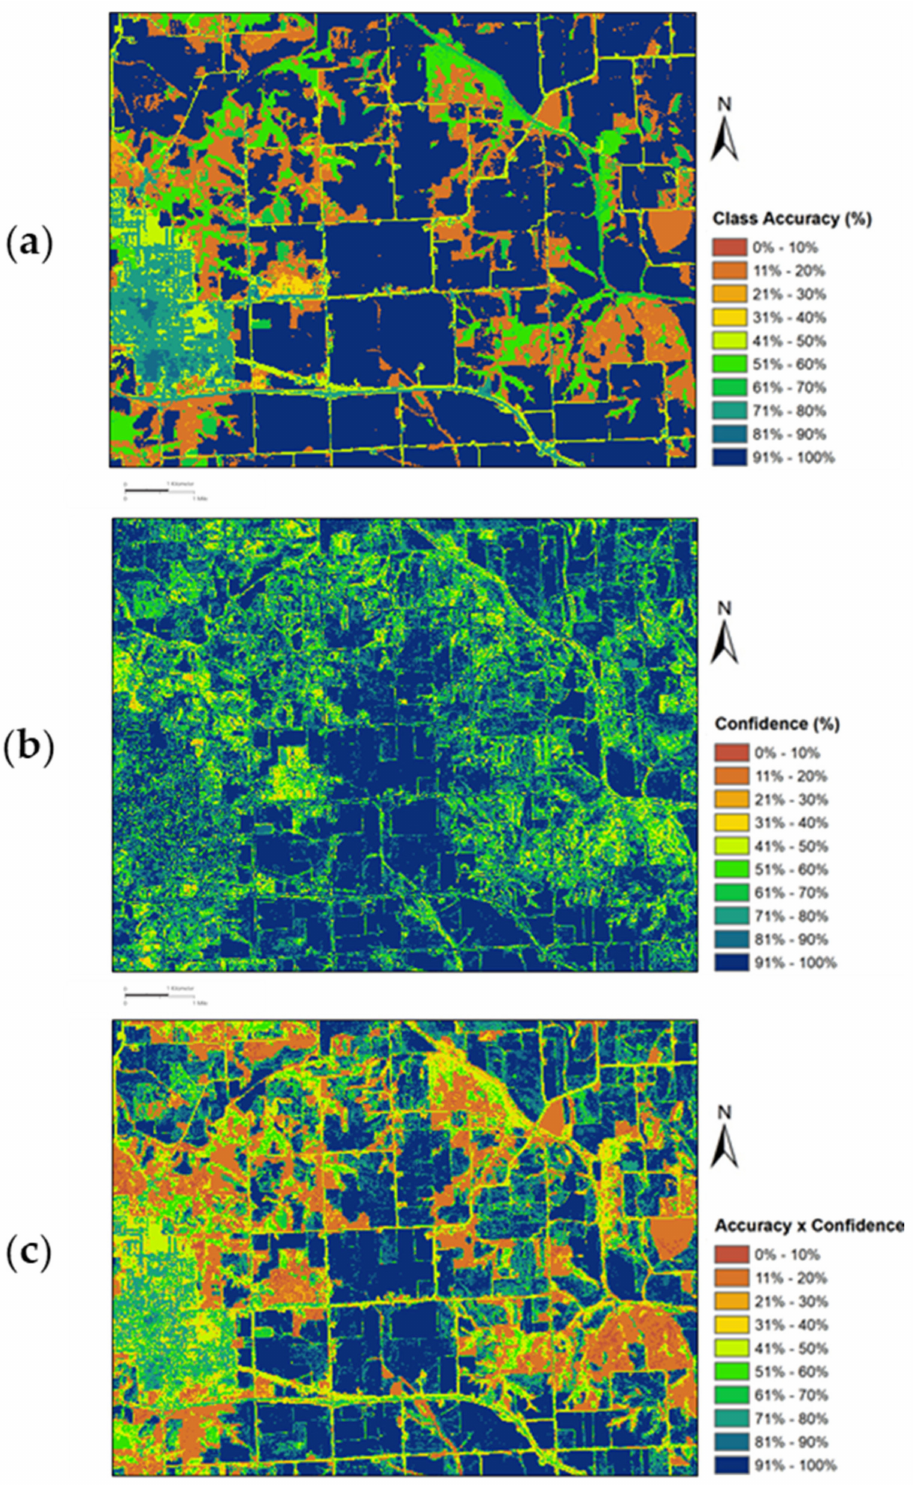
Figure 3. Maps of CDL user’s accuracy ( a ), confidence levels ( b ), and a combined layer of certainty, shown as the product of accuracy and confidence ( c